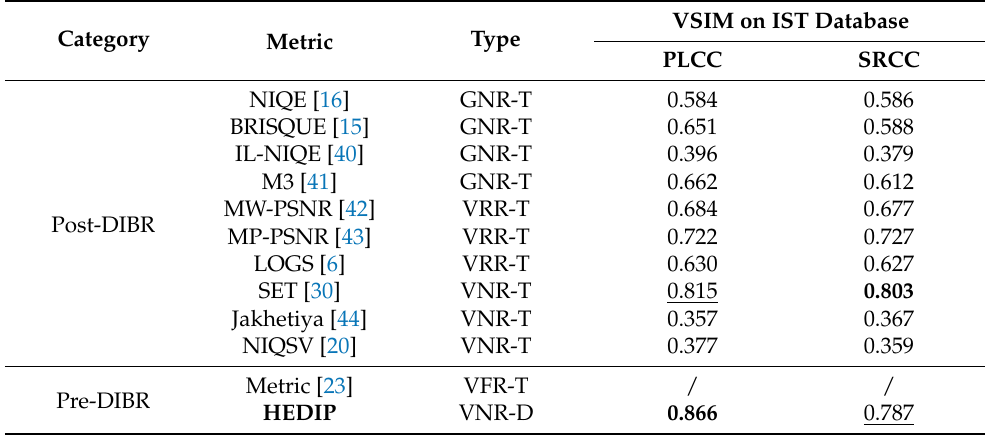
Table 4. Performances of view synthesis quality metrics on the VSIM-based IST database. The best result is highlighted in boldface, and the second best result is underlined.